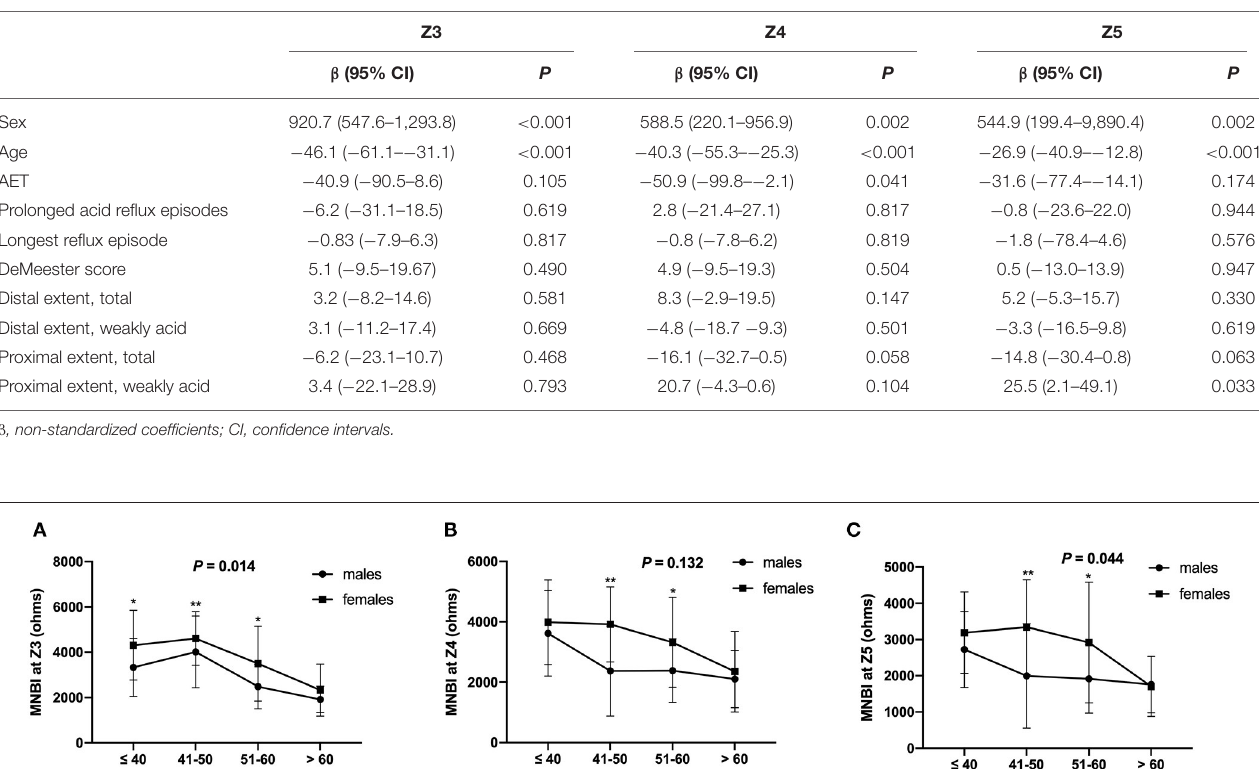
TABLE 5 | Multivariate analyses of sex, age, and reflux episodes on MNBI.